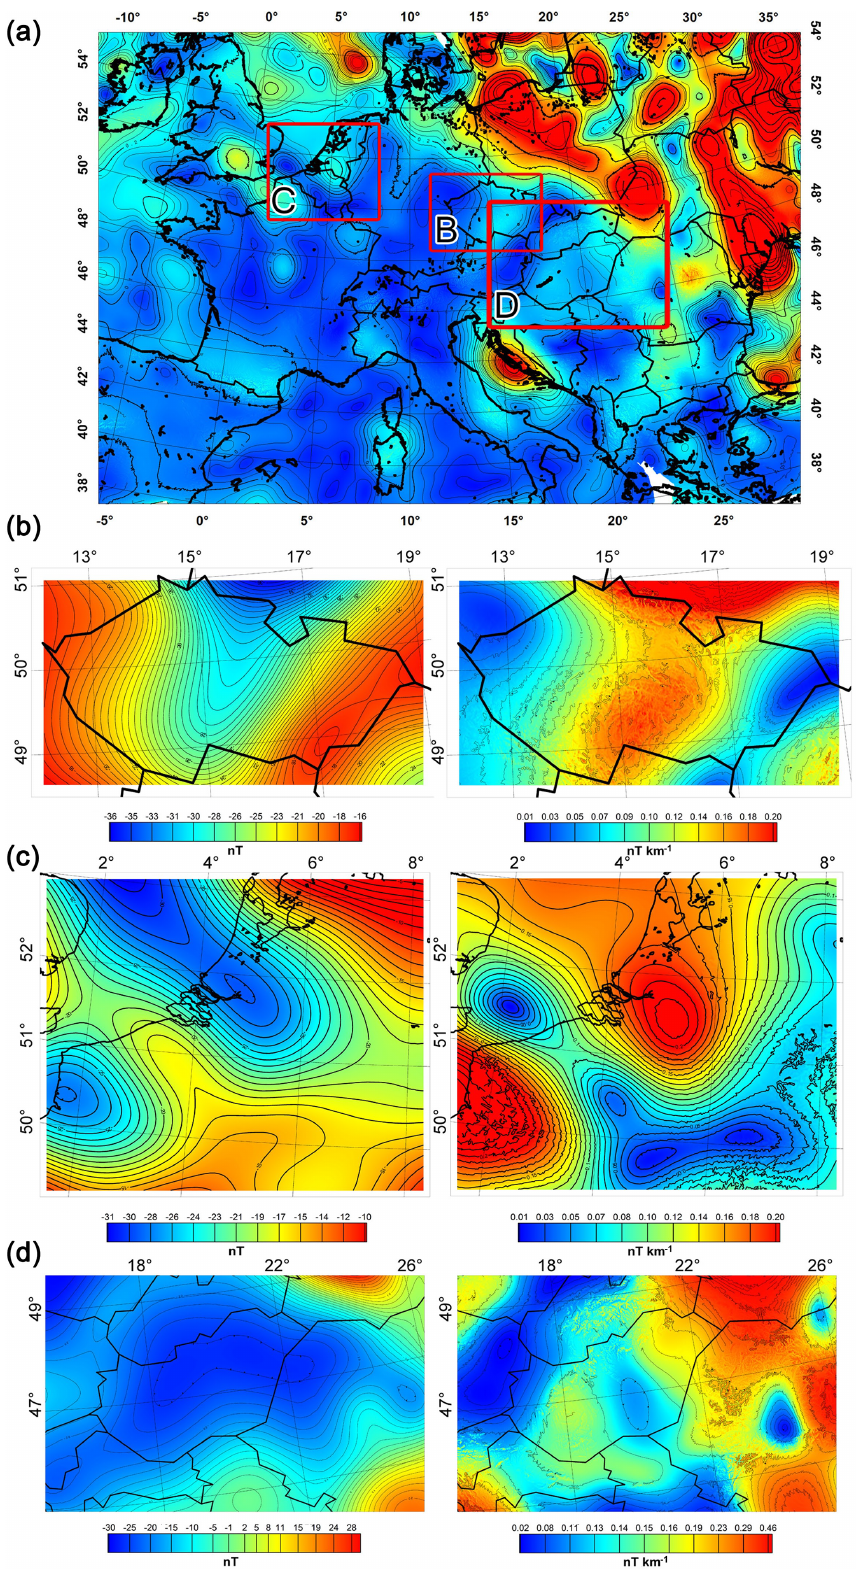
Figure 9. Joint interpretation of magnetic and total gradient anomalies in central Europe (a) over the Bohemian Massif (b) , the Anglo-Brabant Massif (c) and the Pannonian Basin (d)